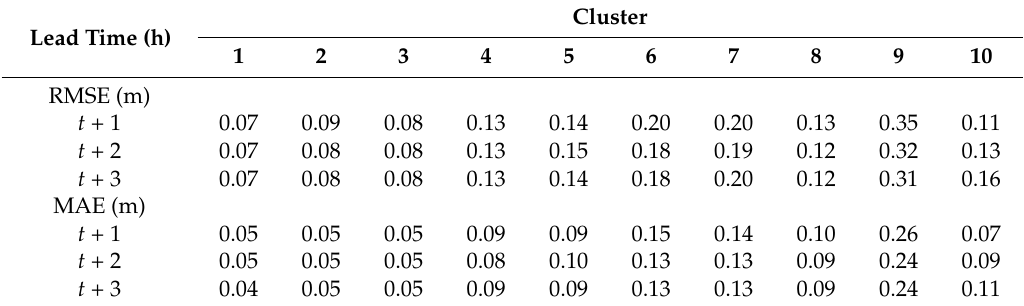
Table 5. RMSE and MAE values for the spatial expansion module for 1–3 h lead time forecasting. Lead Time